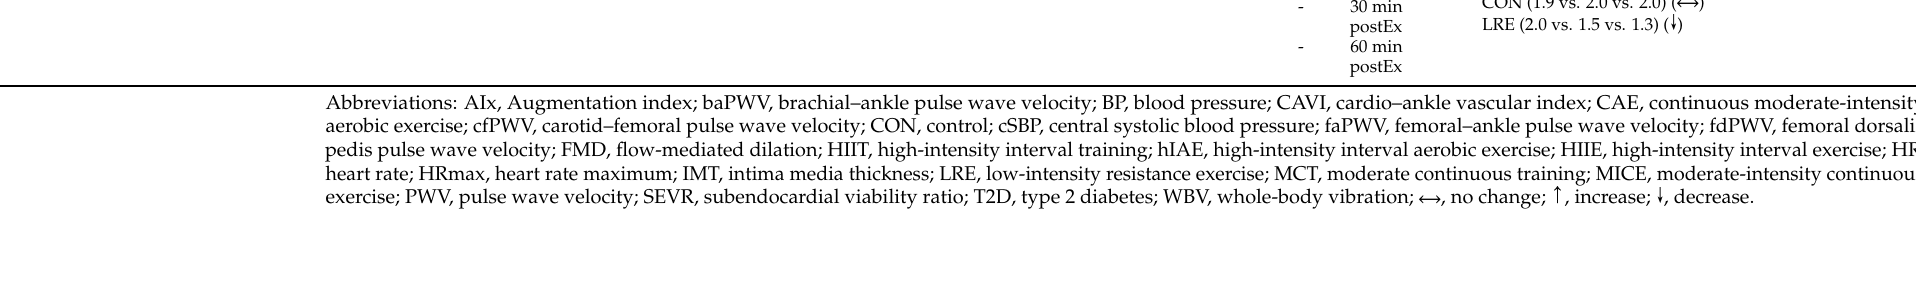
Table 2. Effect of aerobic exercise training on arterial stiffness.